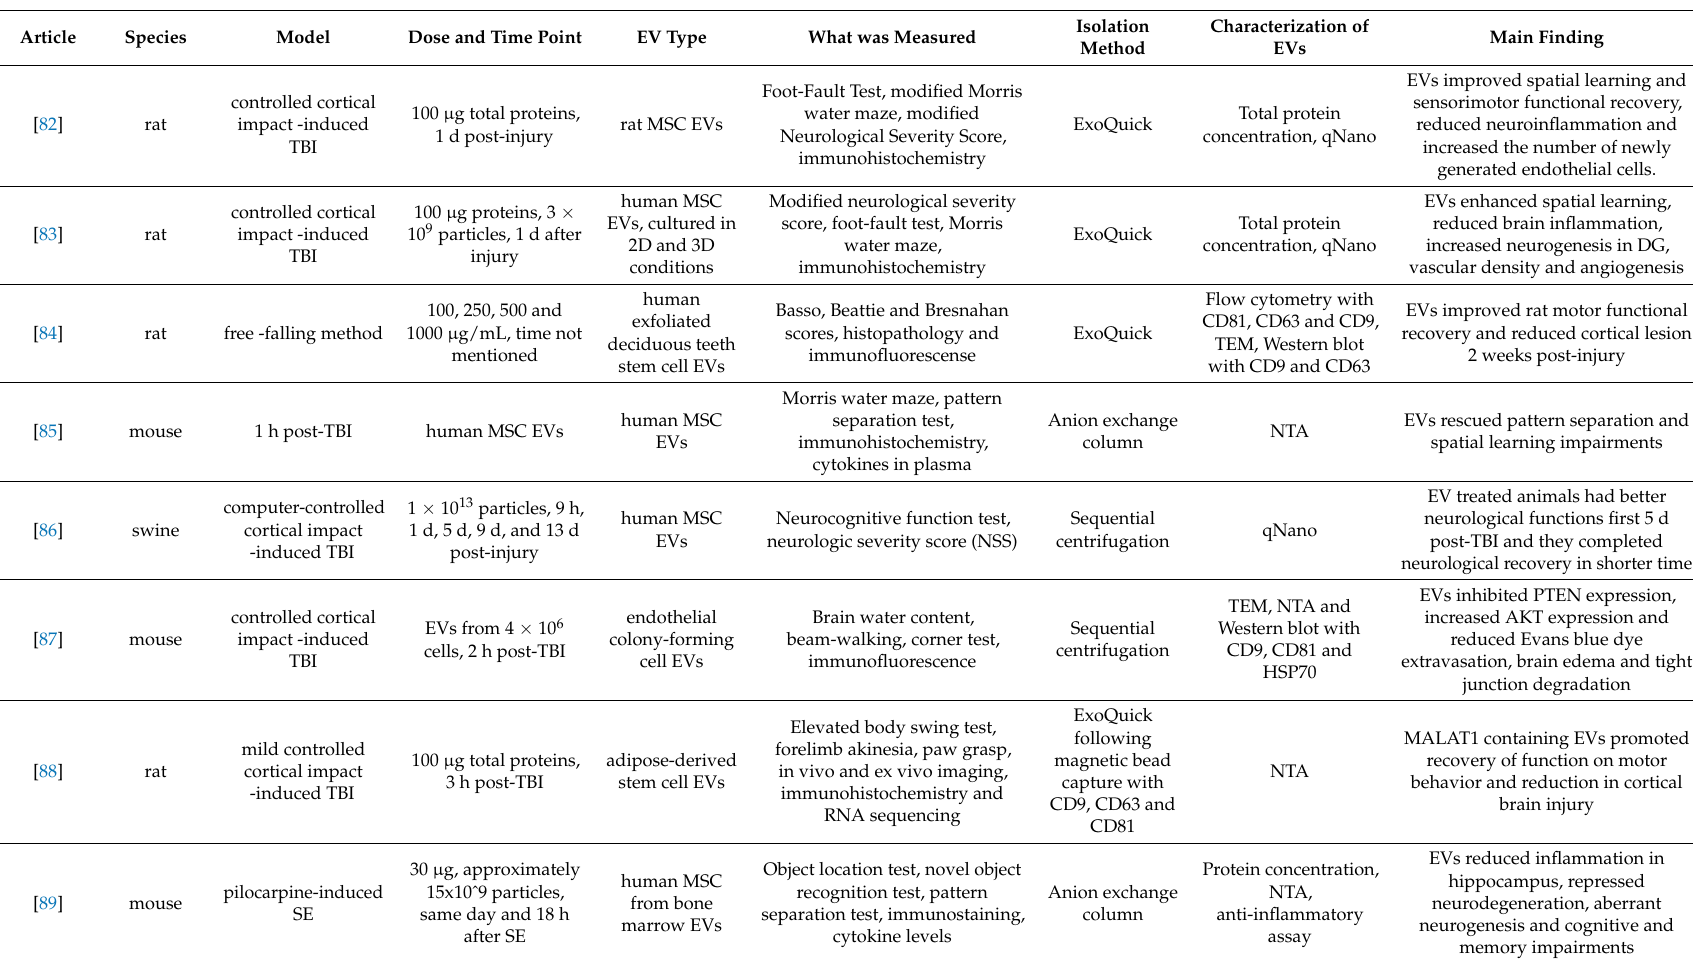
Table 2. Articles describing the beneficial effect of extracellular vesicle (EV) therapy in status epilepticus (SE) and traumatic brain injury (TBI)